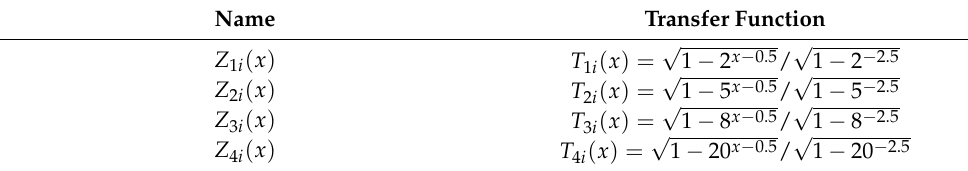
Table 9. The expressions of the improved Z-shaped transfer